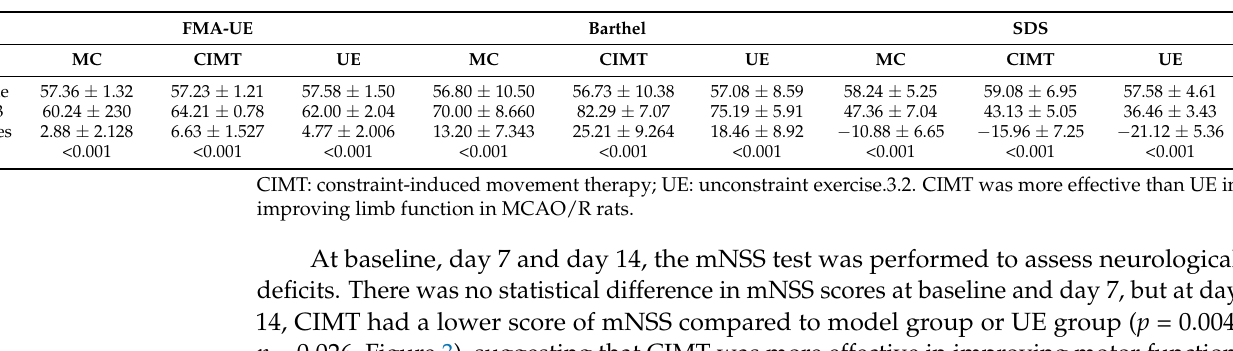
Table 5. The scores of FMA-UE, Barthel, and SDS before and after the interventions.